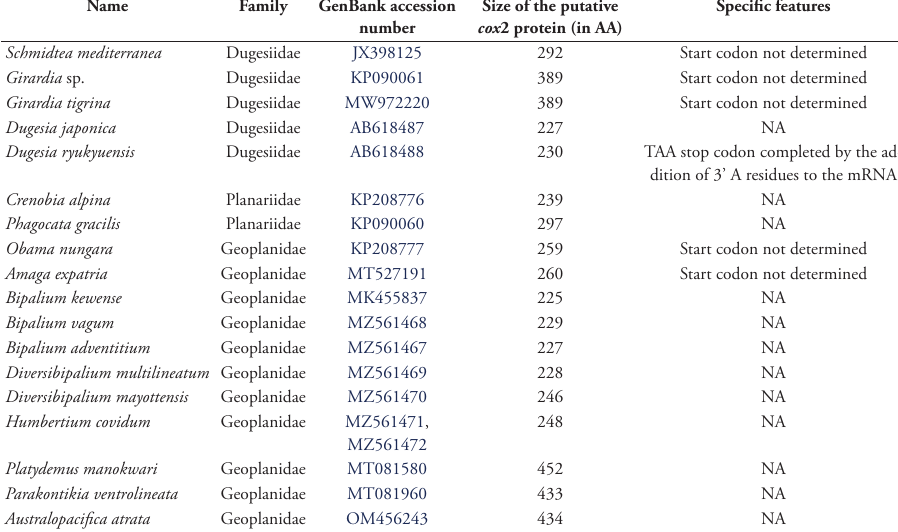
Table 1. Sizes in amino acids (AA) of the cox2 proteins encoded by the available mitogenomes of Con- tinenticola (Tricladida).